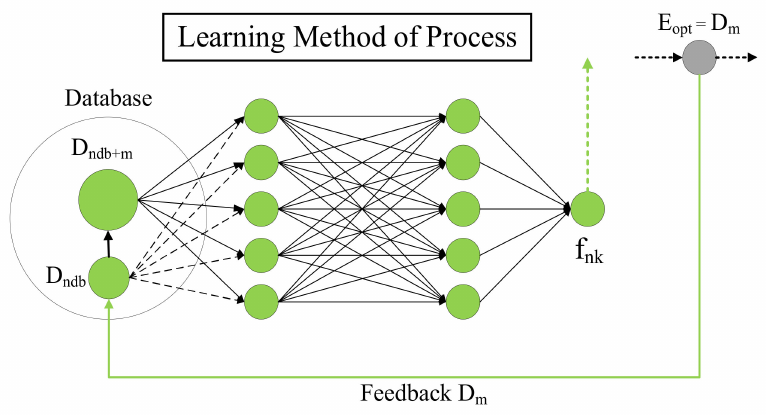
Figure 9. Learning method structure of the preciseness function learning model (PFL